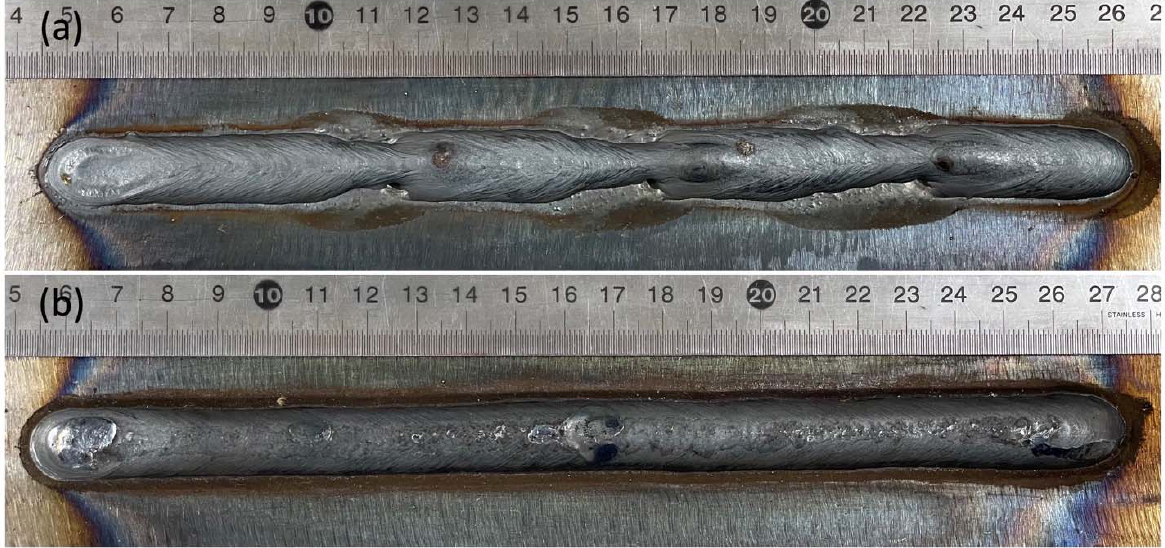
Figure 9. Weld bead appearance of solid wire ( a ) and metal ‐ cored wire ( b ) at 280 A welding